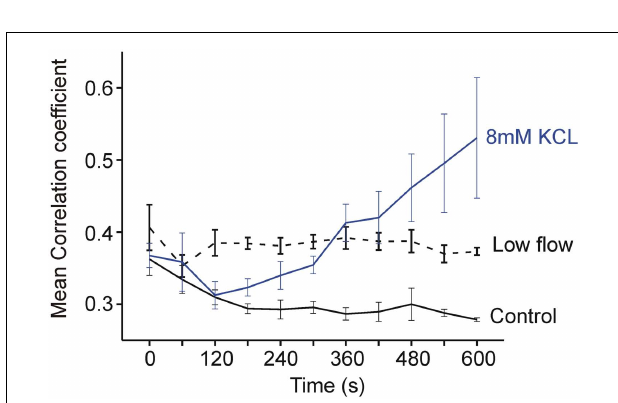
FIGURE 6 | Results from epicardial transmembrane recordings from the LV duringVF. (A) Microelectrode DF duringVF. (B) Membrane potential duringVF in control conditions. (C) Membrane potential during